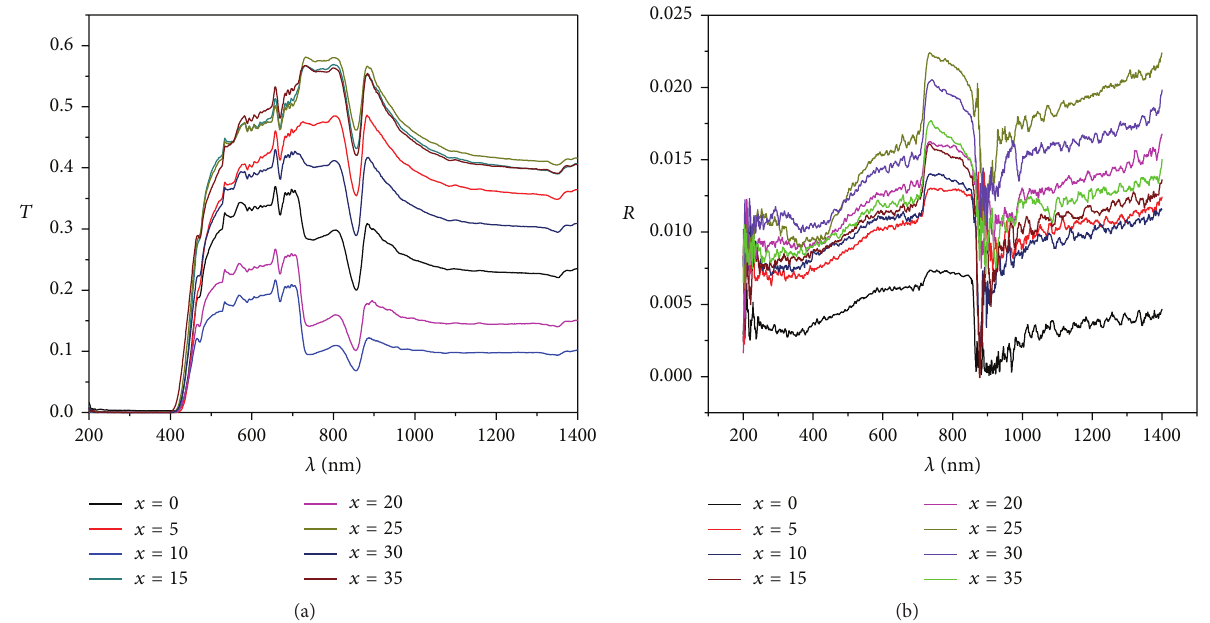
Figure 1: (a) Transmittance ( 𝑇 ) and (b) reflectance ( 𝑅 ) modes for all compositions of 40SiO 2 ⋅ 𝑥 ZnO ⋅ ( 60 − 𝑥 )Bi 2 O 3 glass system.